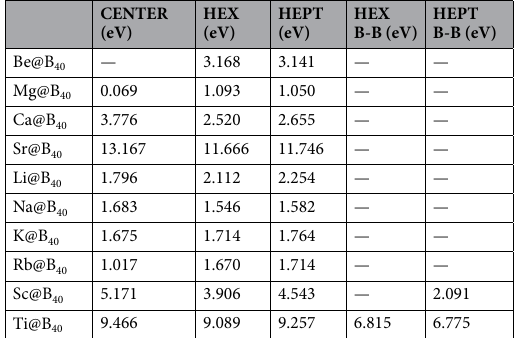
Table 1. The binding energy (in eV) of the single adatom to different sites of the B 40 for the PBE exchange correlation fuctional. These calculations have been carried out using BigDFT for free boundary conditions. The headings CENTER, HEX and HEPT represents the center, hexagonal hole and heptagonal hole of the borospherene respectively. HEX B-B and HEPT B-B represent the B-B bond belonging to the hexagon and heptagon ring